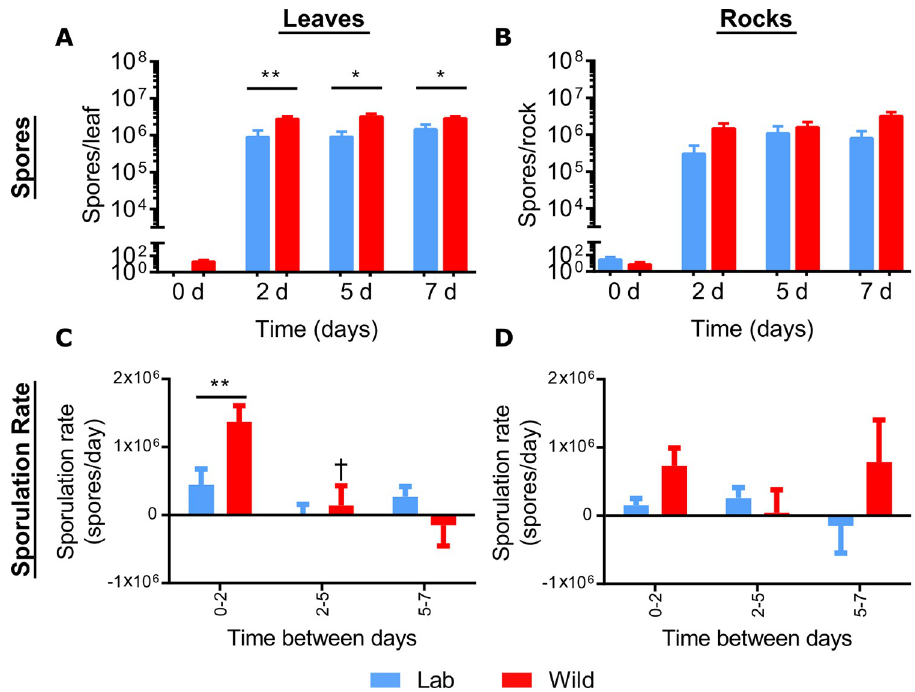
Fig 6. Comparing spores and sporulation rates between grouped fully virulent laboratory-adapted and wild B . anthracis strains on leaf or rock surfaces over 7 days. Grouped laboratory-adapted strains (blue) are the averaged spore titers from Ames (UF00738) and Vollum (UF00980) and grouped wild strain values (red) are the averaged spore titers from the Ames-like (UF01106) and Vollum-like (UF01103) strains. Sporulation rates (spores/day) were calculated from the slope of the lines between each timepoints and graphed on a linear scale. Data are presented as the mean ± SEM for (A) total spores recovered from leaves, (B) total spores recovered from rocks, (C) sporulation rate from leaves, and (D) sporulation rate from rocks. The significant differences between laboratory-adapted and wild strains at each time point were determined by Mann-Whitney U tests with � = ρ < 0.05 and �� = ρ < 0.01. Significant differences in sporulation rates between days were determined by Kruskal-Wallis and Dunn’s multiple comparisons tests with leaf temporal differences identified by † = ρ <